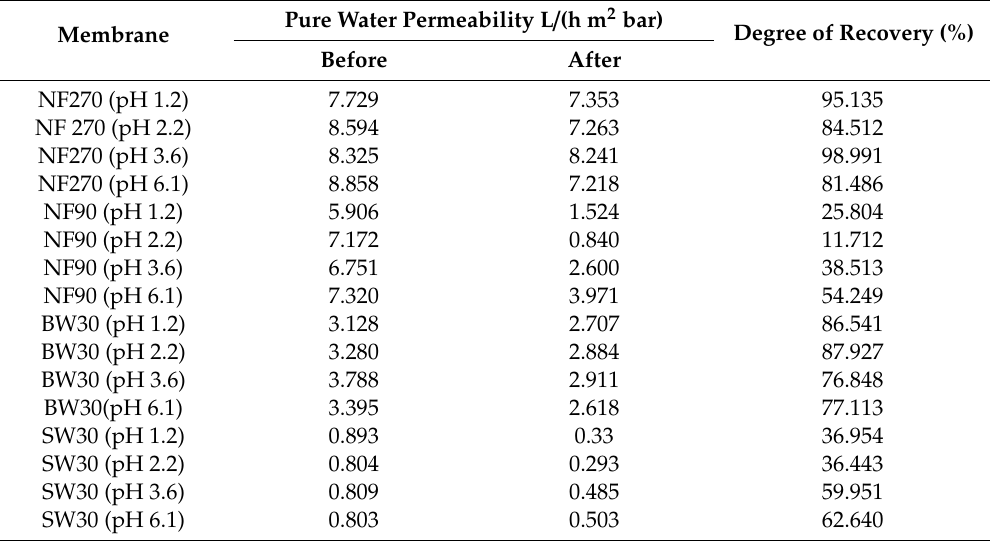
Degree of Recovery (%)